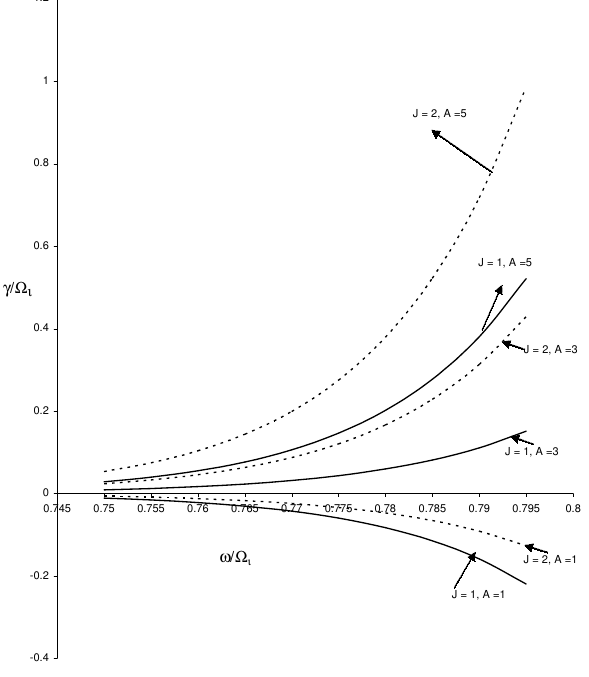
Fig. 4. Variation of growth rate ( γ / (cid:127) i ) versus wave frequency ( ω / (cid:127) i ) for different values of thermal anisotropy (A) and distribu- tion index J =1, 2, V D = − 3 × 10 7 cm/s. Fig.4 Variation of growth rate ( g / W i ) versus wave frequency ( w / W i ) for different values of thermal anisotropy (A) and distribution index J=1,2 , V D = -3 x 10 7 cm/sec.